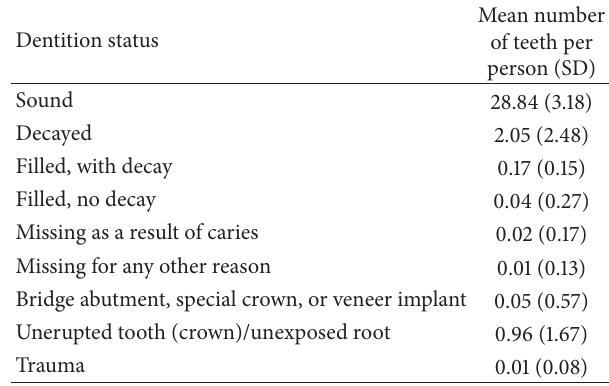
Table 2: Distribution of pregnant women according to loss of attachment.